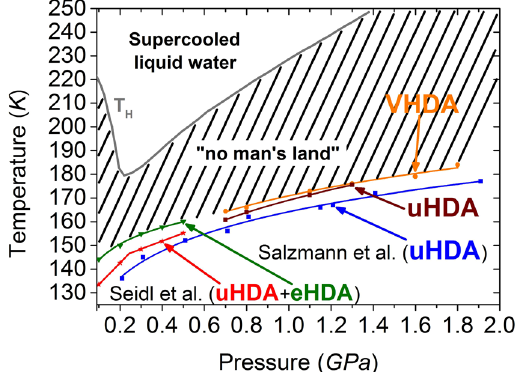
Figure 7. Borders to the no man’s land: T H from 38 and T X for different amorphous ices. In all experiments an intermediate heating rate was applied (2–5 K min − 1 ) to determine T X . Studies of Seidl et al . 32 are colour coded in red (eHDA) and green (uHDA). Studies of Salzmann et al . in blue (uHDA) 30 . Results of this present study on VHDA in orange and on uHDA in